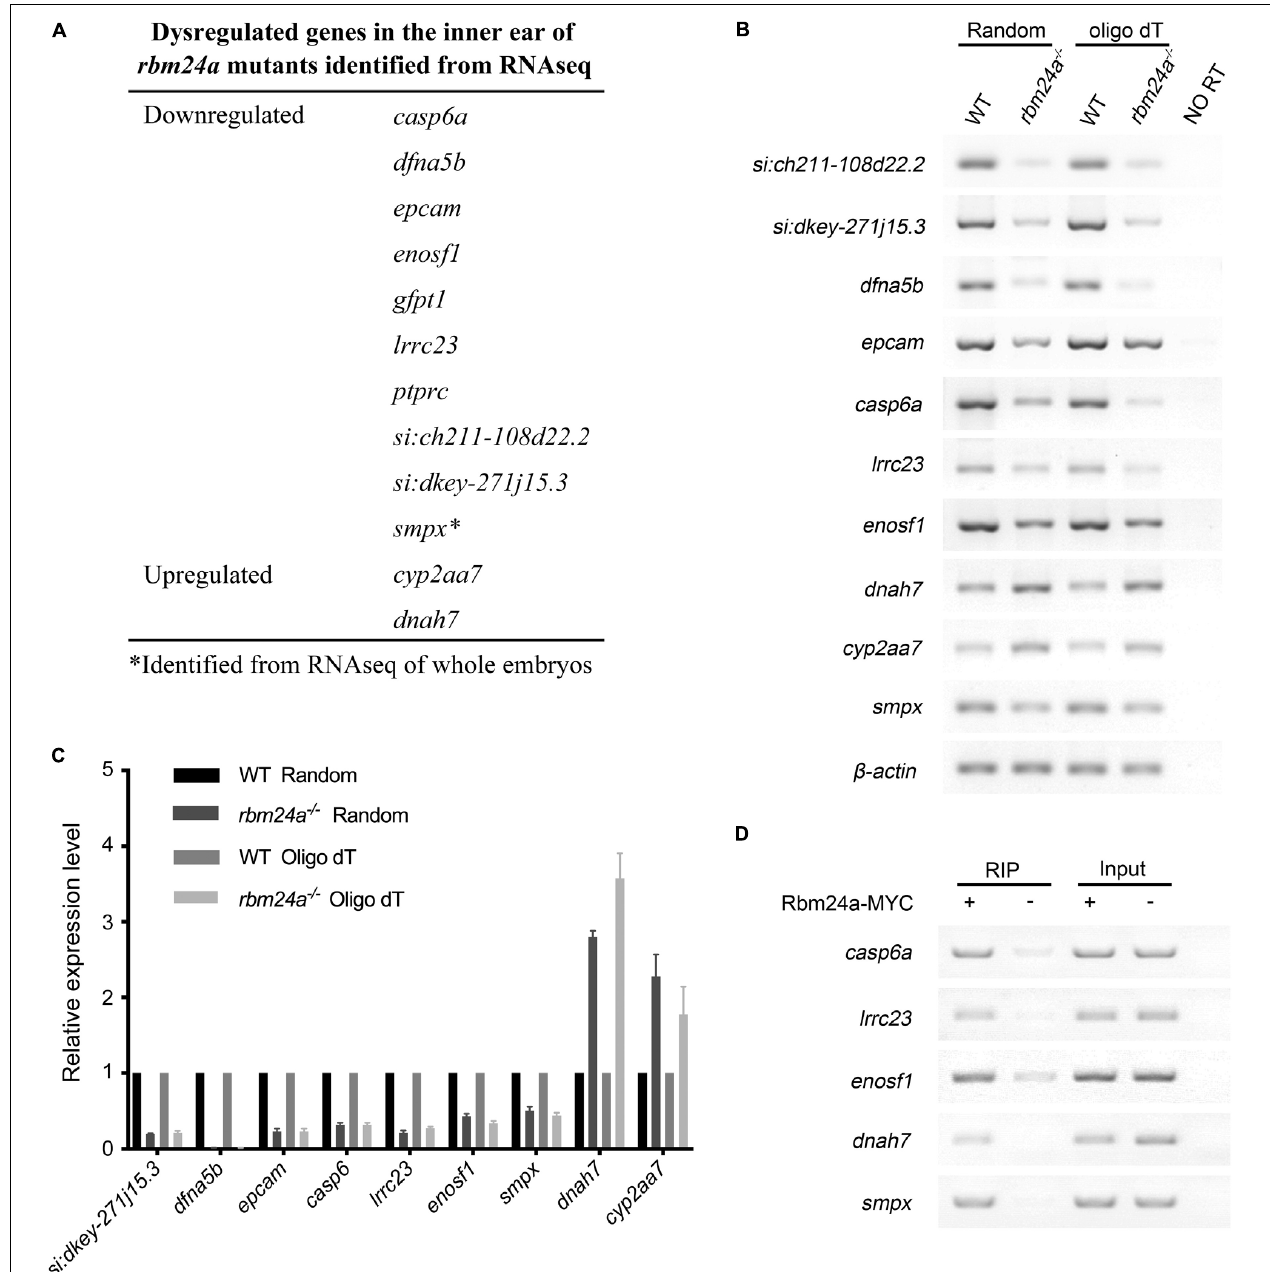
FIGURE 7 | Dysregulated genes in the inner ear of rbm24a mutants. (A) Dysregulated genes in the inner ear of rbm24a mutants identified from RNAseq analysis. RT-PCR (B) and qPCR (C) were performed to confirm the RNAseq results. Random primers or oligo dT were used as primers for reverse transcription as indicated. (D) RIP experiments were performed to examine the binding of Rbm24a with its target mRNAs. Statistical analysis of the qPCR results shows that the expression difference is significant ( P value < 0.000001, except that P value of cyp2aa7 is 0.001315).